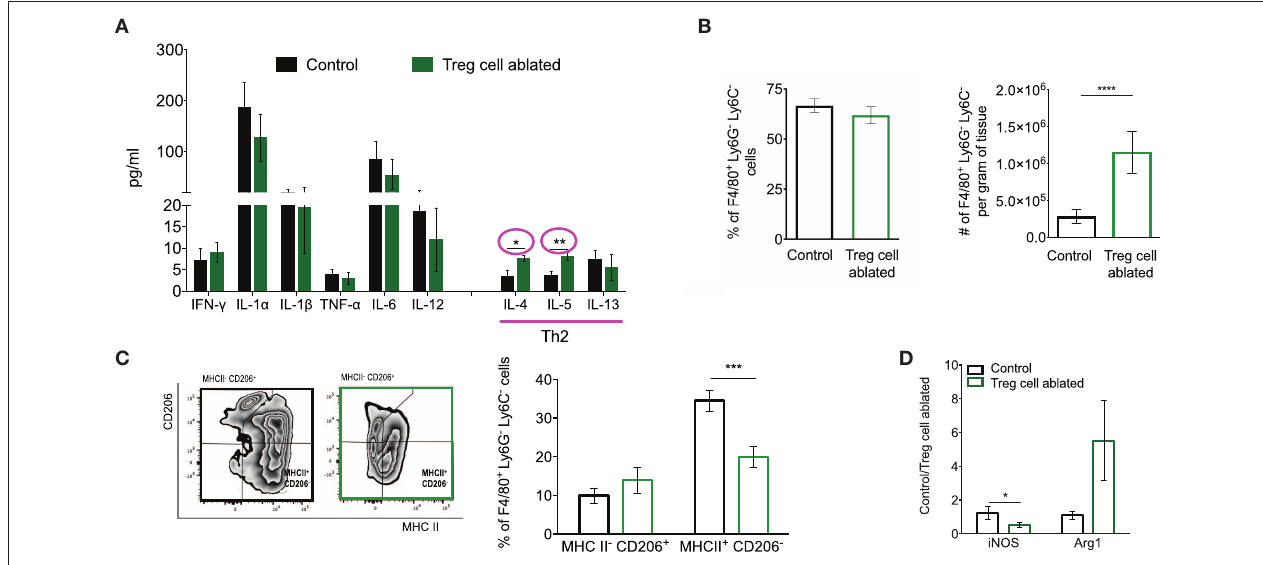
FIGURE 4 | Treg cell ablation results in an immune microenvironment associated with tumor progression. (A) Multiplex analysis of shown cytokines. Values are expressed as mean ± SEM, n = 3 mice per group. * p = 0.0278 and ** p = 0.0082 were calculated by unpaired t -test. (B) Percentage (left) and absolute number (right) of tumor associated macrophages (CD11b + LY6C − LY6G − F4/80 + ). **** p < 0.0001 was calculated by Mann–Whitney test. (C) Representative flow cytometric plot (left) and quantification (right) of TAM (Ly6G − Ly6C − F4/80 + ) cell polarization as relative amounts of MHCII − CD206 + and MHCII + CD206 − cells. *** p < 0.0007 was calculated by two-way ANOVA, followed by Bonferroni’s post-hoc test. (D) Mammary gland relative expression of iNOS and Arg-1 (M1 and M2 markers, respectively) quantified by qPCR. Values are expressed as mean ± SEM and were normalized by F4/80 and beta-actin levels. n = 5–6, * p = 0.0479 was calculated by unpaired t -test. Data were pooled from two independent